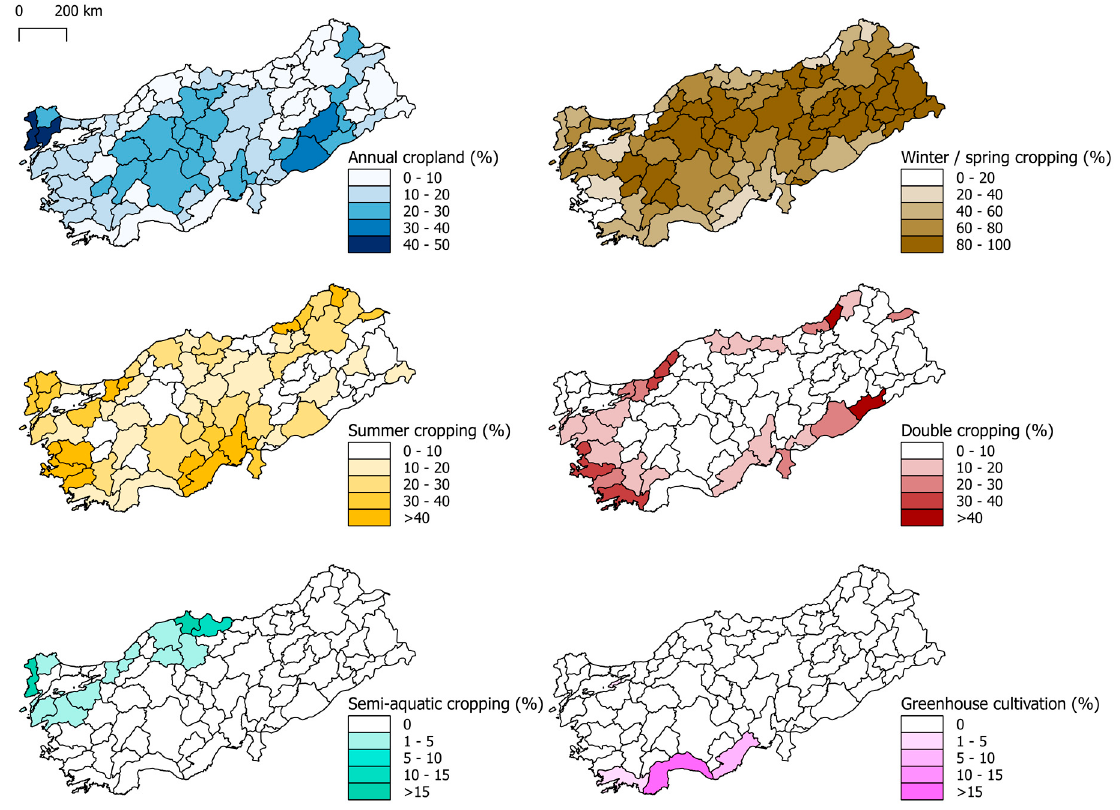
Figure 8. Province-level (NUTS-03) share of annual cropland on total province area (top left) and shares of cropping practices in percent of all cropland (remainder).